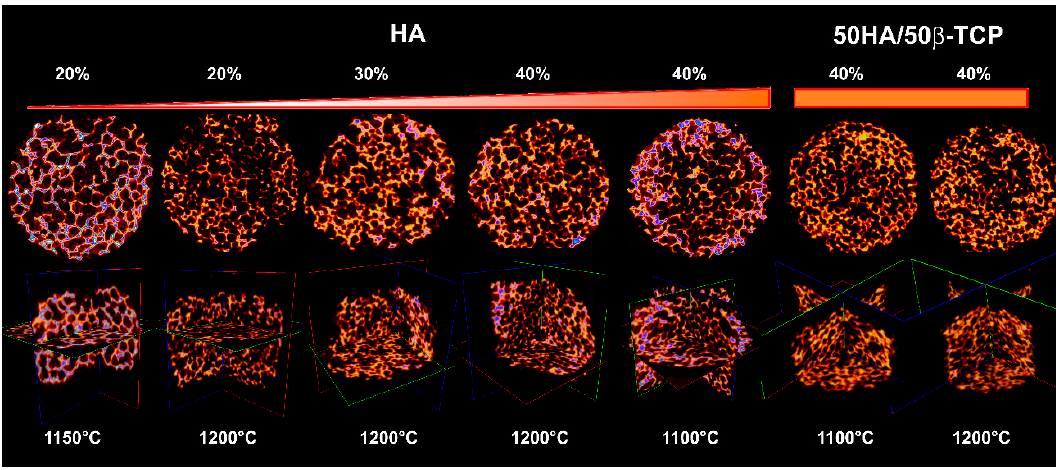
Figure 8. µ CT reconstruction of pure HA and 50HA/50 β -TCP biphasic scaffolds.